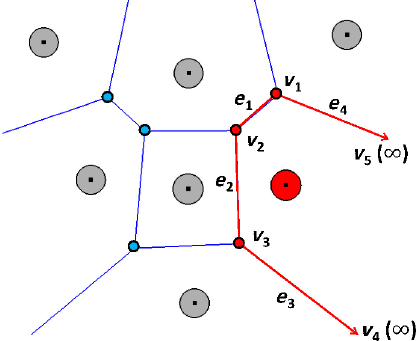
Fig. 10 An expanding unbounded Voronoi cell (red) with: regular cell vertices v 1 – v 3 , cell vertices at infinity v 4 , v 5 ; regular cell edges e 1 , e 2 , and infinite cell edges e 3 , e 4